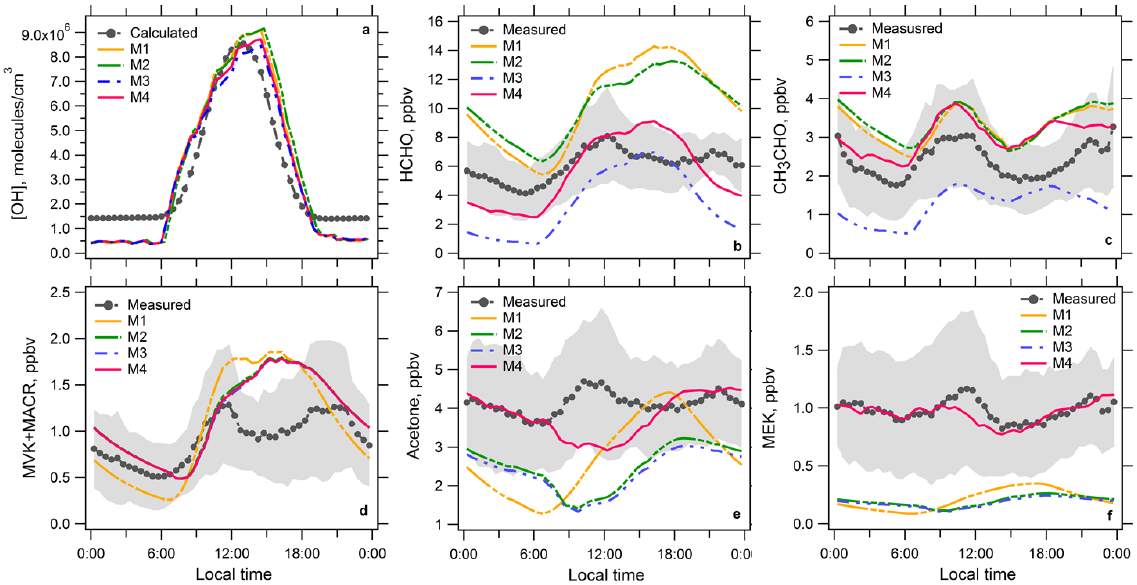
Figure 6. The 30min average modeled and measured (or calculated) concentrations of (a) OH radical, (b) HCHO, (c) acetaldehyde, (d) MVK + MACR, (e) acetone and (f) MEK plotted as diurnal patterns from 26 July to 27 August. The dashed black lines with solid dots indicate measured (or calculated) data, grey areas show one standard deviation from the averaged values. The dash-dotted yellow lines, dashed green lines, dash-dotted blue lines and solid magenta lines represent the modeled concentrations by simulations M1, M2, M3 and M4,